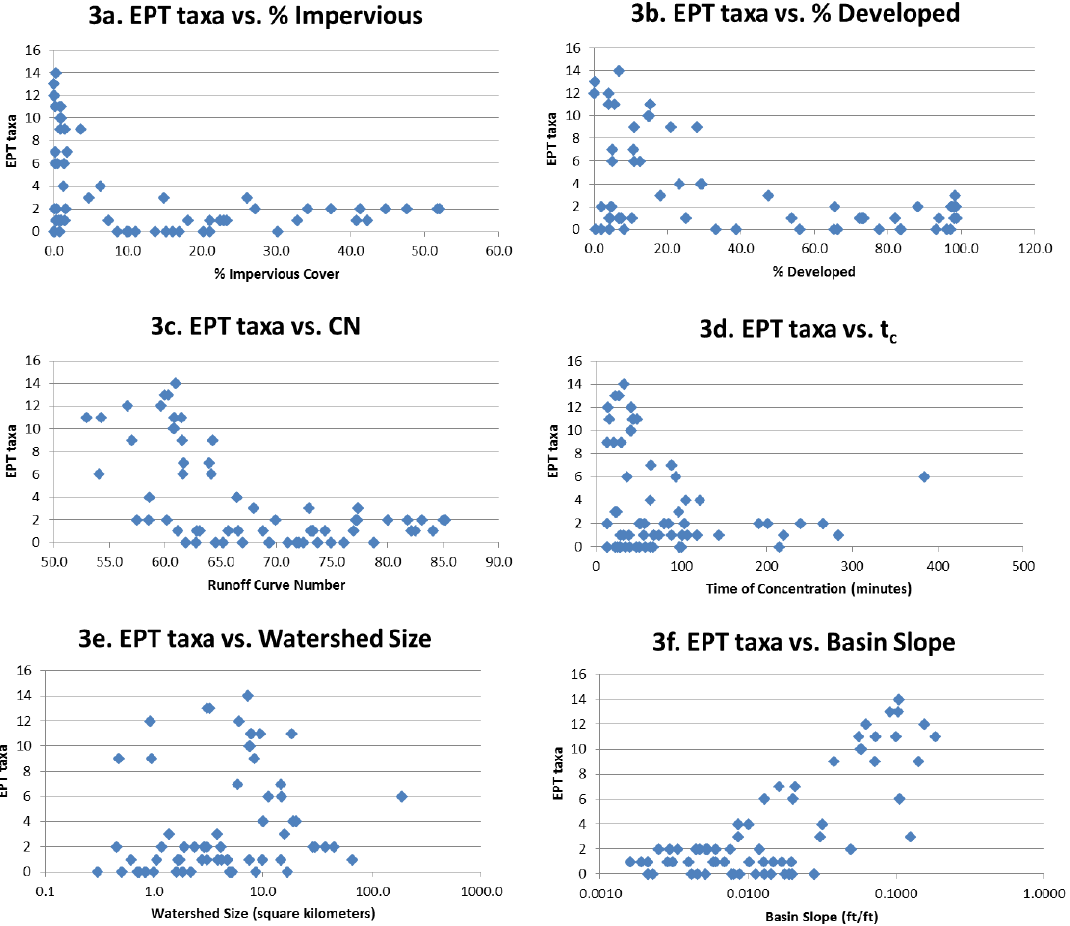
Figure 3. EPT taxa plotted in relation to six watershed parameters (n = 65 streams) with ( a ) EPT taxa versus % Impervious cover; ( b ) EPT taxa versus % Developed; ( c ) EPT taxa versus curve number; ( d ) EPT taxa versus time of concentration; ( e ) EPT taxa versus watershed size in square kilometers; ( f ) EPT taxa versus basin slope.